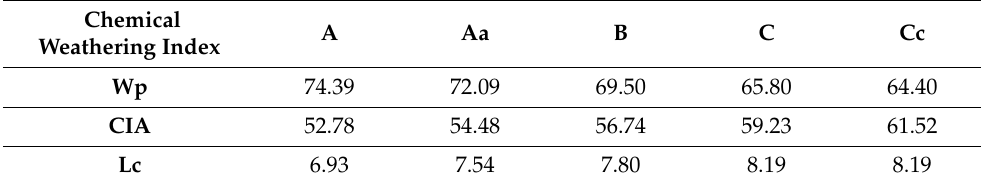
Table 4. Results of the calculation of chemical weathering indexes.